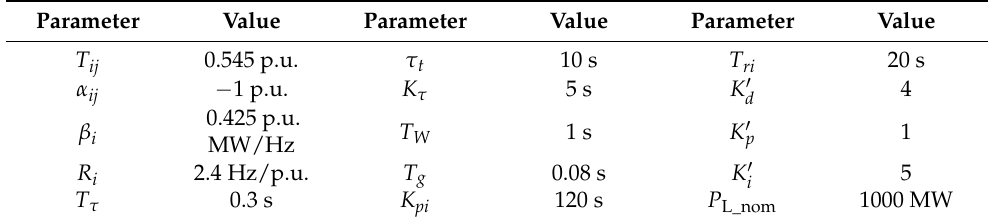
Table 2. Basic parameters of the interconnected grid